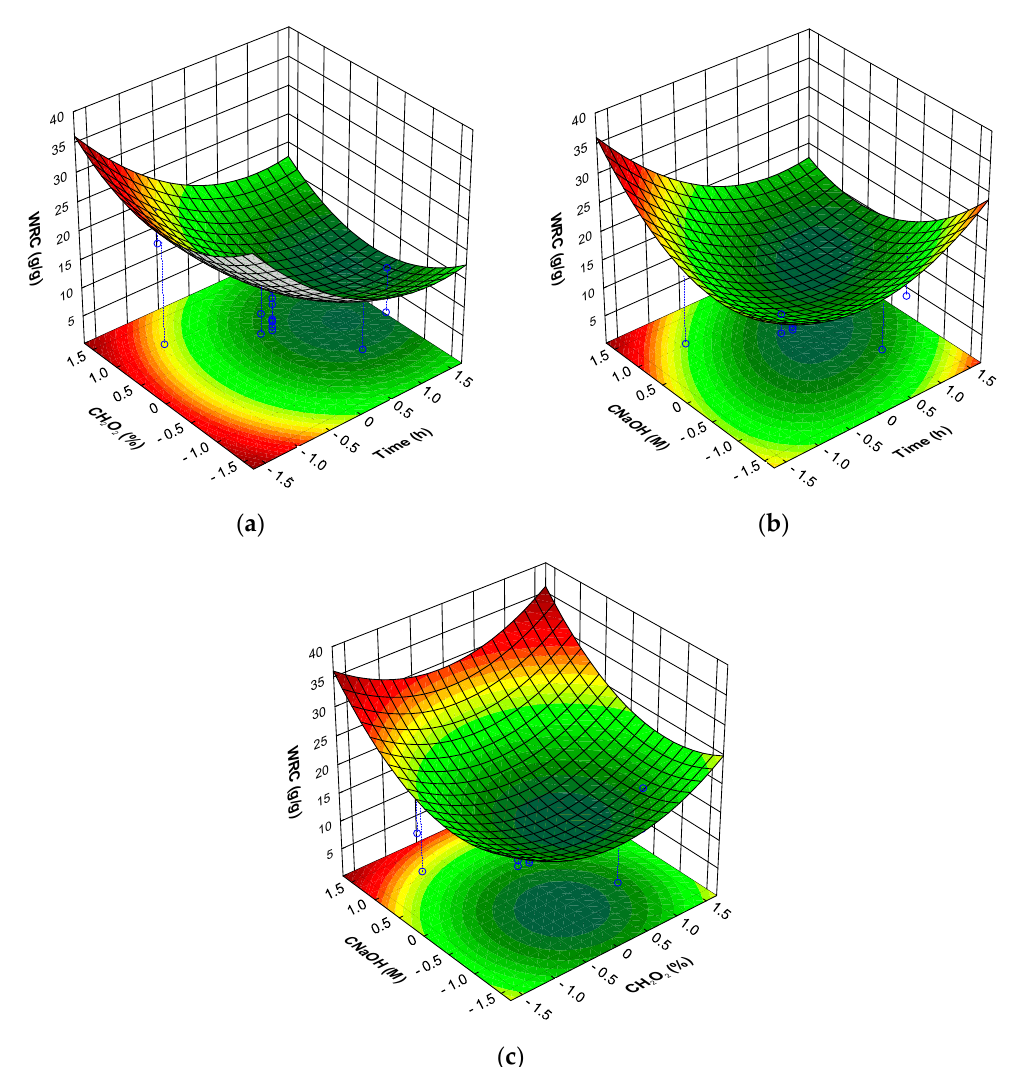
Figure 4. Response surfaces for mushroom DFI water retention capacity (WRC) as a function of: ( a ) time and hydrogen peroxide concentration (at sodium hydroxide concentration level of 1.682); ( b ) time and sodium hydroxide concentration (at hydrogen peroxide concentration level of 1.682); ( c ) hydrogen peroxide concentration and sodium hydroxide concentration (at time level of − 1.682).